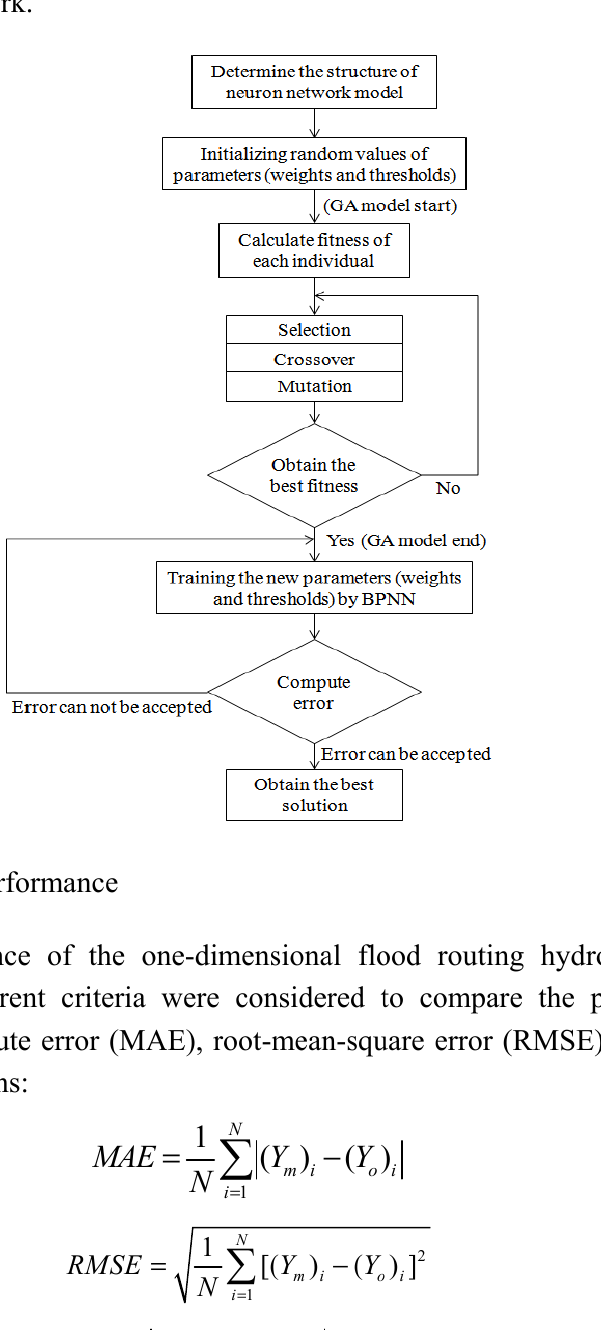
Figure 3. Flow chart of the ANN method linked with the GA optimizer. BPNN, back propagation neural